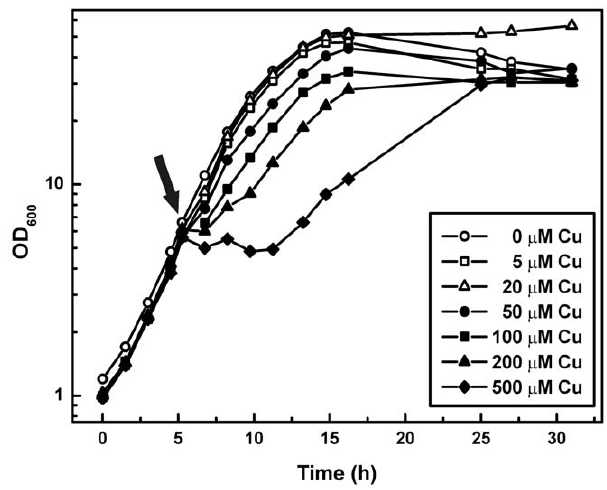
Figure 1. Influence of different copper ion concentrations on the growth of C.glutamicum wild type. Cells pregrown in CGXII minimal medium with 4% (w/v) glucose were used to inoculate 50 ml of fresh CGXII medium (1.25 m M CuSO 4 ). When the cultures had reached an OD 600 of about 5–6, different CuSO 4 concentrations were added (indicated by an arrow). The cultures were incubated at 30 u C on a rotary shaker at 120 rpm. The growth curves shown here are representative of those from three independent growth experiments with comparable results.